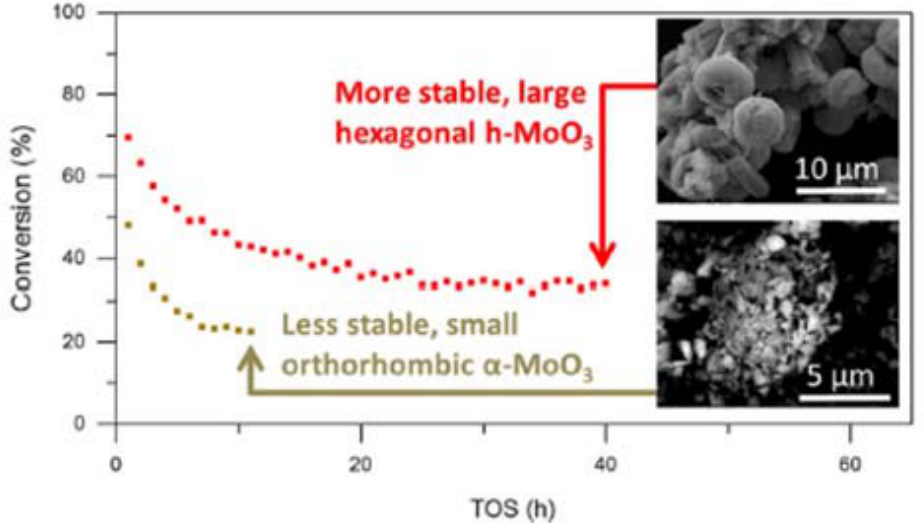
Figure 4. The detailed examination of the iron molybdate surface produced with a new physical milling method confirmed that the presence of molybdenum content affects both the structure and the catalysts’ performance. Reprints from [51]. Copyright (2021), with permission from Springer